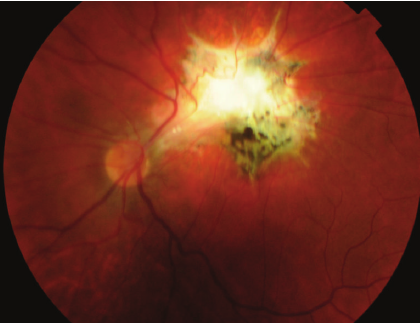
Figure 3: Color photo of the right eye showing superior